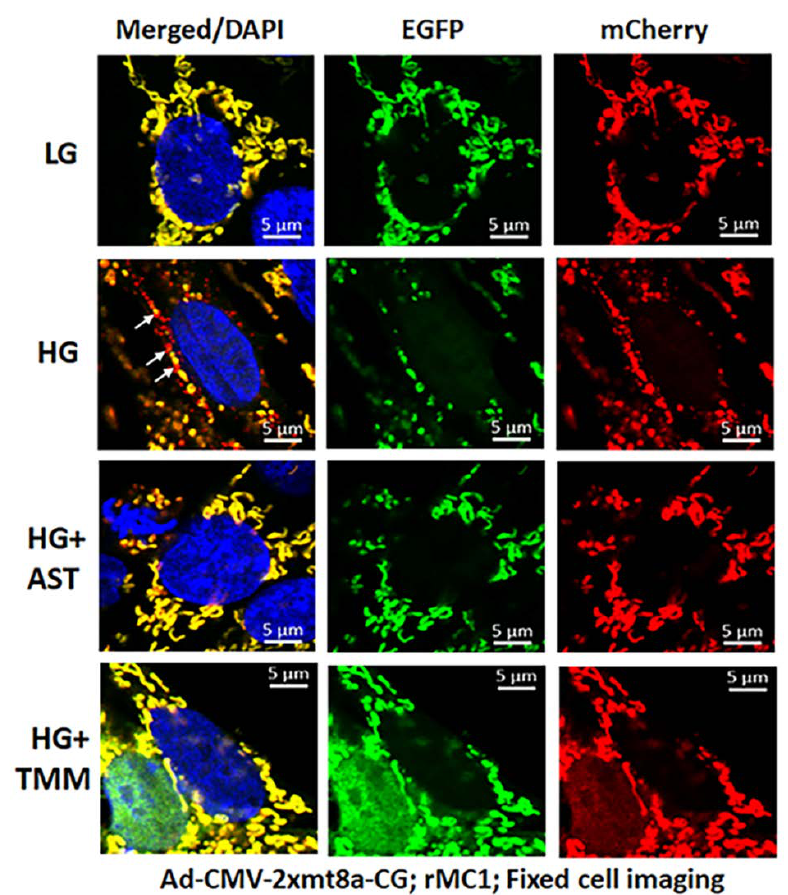
Figure 8. Combination triple drug treatment reduces mitophagy in rMC1 under HG in fixed-cell Figure 7. Combination triple drug treatment reduces mitophagy in rMC1 under HG in live-cell im- imaging. rMC1 cells were transduced with 2 × mt8a-CG (mCherry-EGFP) for 3 days under HG or LG aging. rMC1 cells were transduced with 2×mt8a-CG (mCherry-EGFP) for 3 days under HG or LG. similar to live-cell imaging. When drug treatments were performed, they were added 24 h before When drug treatments were performed, they were present for 24 h before the confocal live-cell im- fixing the cells. Nuclei were counter-stained with DAPI (blue). HG increases red mitolysosome aging. We observed that HG increases red mitolysosome formation (white arrows, HG second panel) when compared to LG. Active mitochondria show yellow (red and green), while damaged formation (while arrows, HG second panel) in rMC1 cells than in LG. Active mitochondria show mitochondria after flux to lysosomes yield red due to EGFP (green) quenching. Interestingly, com- yellow (red and green), while damaged mitochondria emit red in lysosomes due to EGFP (green) bination triple drug treatment with AST (amlexanox, SS-31 and tranilast) or with TMM (TXNIP- quenching. AST (amlexanox, SS-31 and tranilast) or TMM (TXNIP-IN1+Mito-Tempo+ML-SA1) IN1+Mito-Tempo+ML-SA1) reduces mitophagic flux in rMC1 under HG (last two panels, respec- reduces mitophagic flux in rMC1 under HG (last two panels, respectively). A representative of n = 3 tively). A representative of n = 3 is shown here, captured at 630× magnification in a Zeiss confocal is shown here, captured at 630 × magnification in a Zeiss confocal microscope.